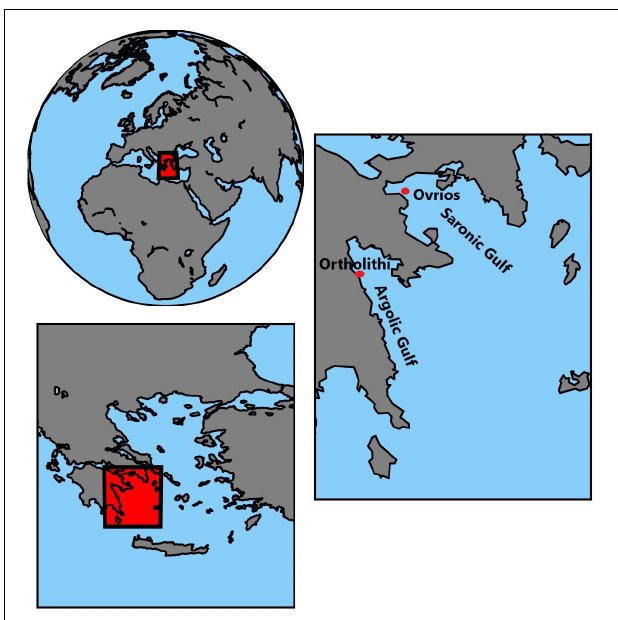
FIGURE 1 | Location of the study area with two Gulf areas and two observation points – Ortholithi and Ovrios.